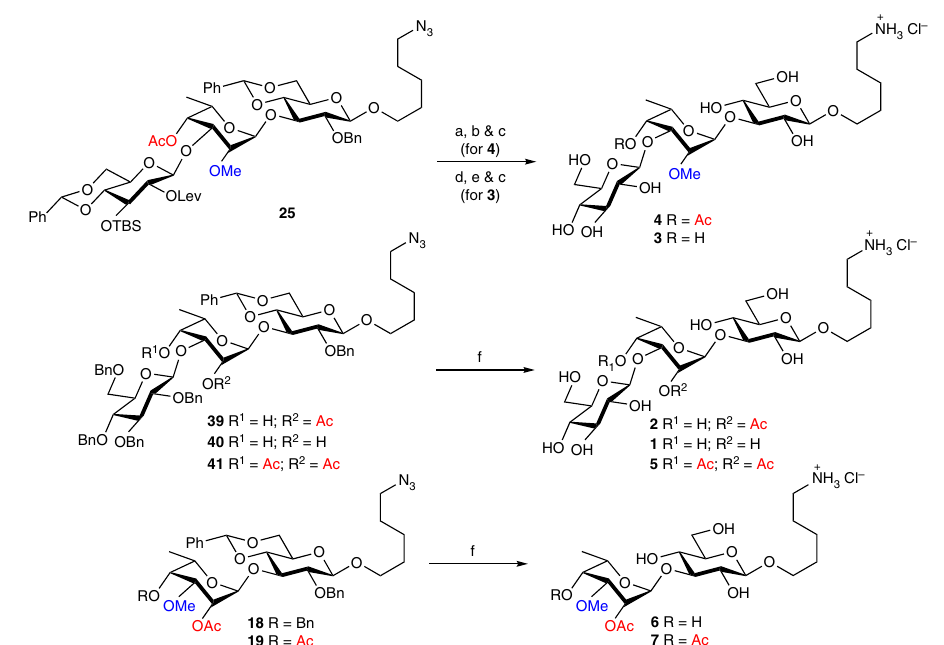
Fig. 4 Global deprotection allowing access to target oligosaccharides. Reagents and conditions: a H 2 NNH 2 .HOAc, MeOH/DCM 5:2, RT, overnight; b TREAT-HF, THF, re fl ux, 24 h, 92% (over two steps); c H-Cube, 20% Pd(OH) 2 /C, HCl (2.0 equivalents), 10 bars, 40 °C, MeOH/DCE, 78% (for 4 ); 78% (for 3 ); d NaOMe, MeOH/DCM 2:1, RT, overnight; e TBAF, THF, 0 °C to RT, overnight, 89% (over two steps); f Pd black, H 2 , HCl (1.0 equivalent), MeOH/DCE, quant. (for 1 , 2 , 5 , 6 , and 7 ). TBAF tetrabutylammonium fl uoride, TREAT-HF triethylaminetrihydro fl